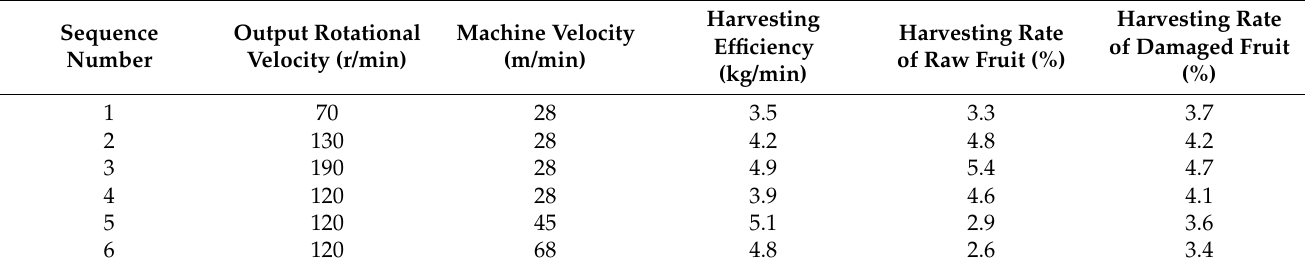
Table 4. Results of the blueberry harvesting field